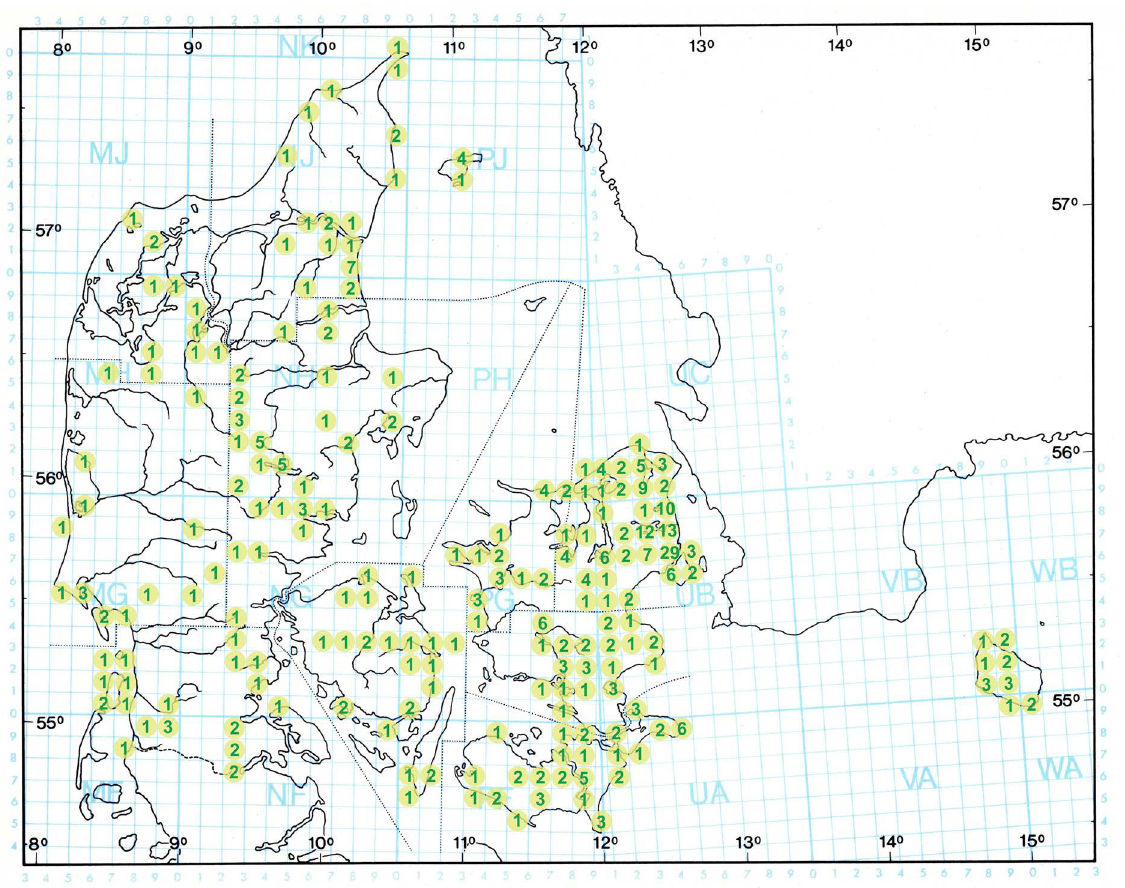
Fig. 94. Number of localities with sampled Laboulbeniomycetes for UTM 10×10 km